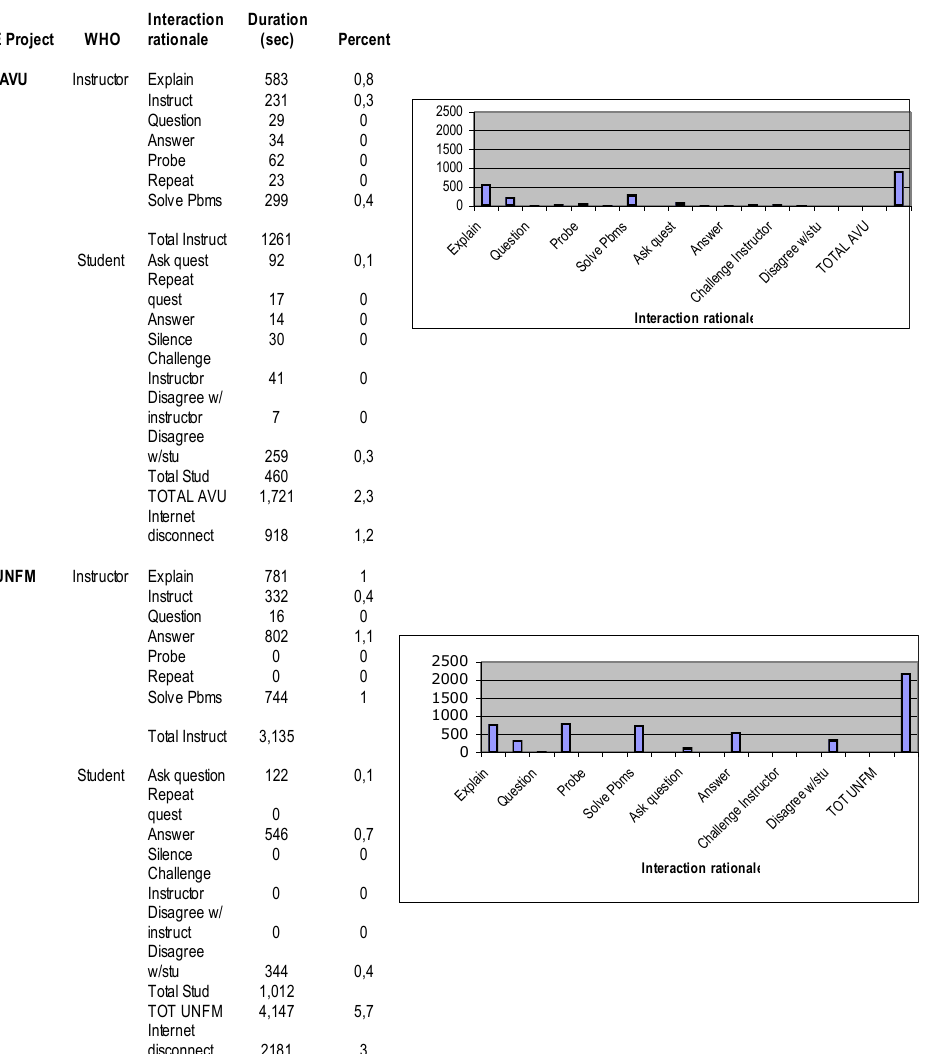
Mean and Percentage Duration for Interaction Events (20 Hours